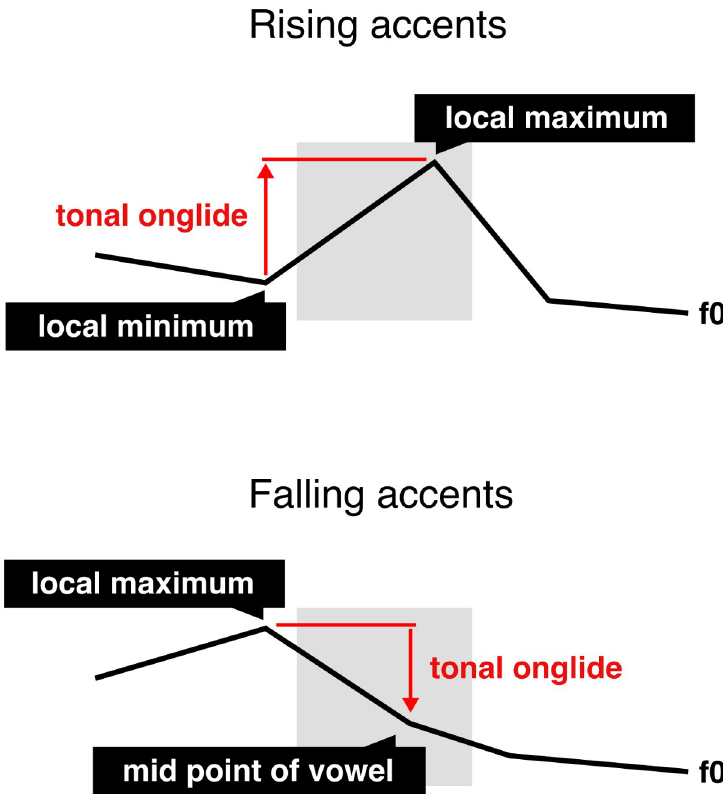
Fig 8. Schematic depiction of the onglide measure for rising accents (top) and falling accents (bottom).